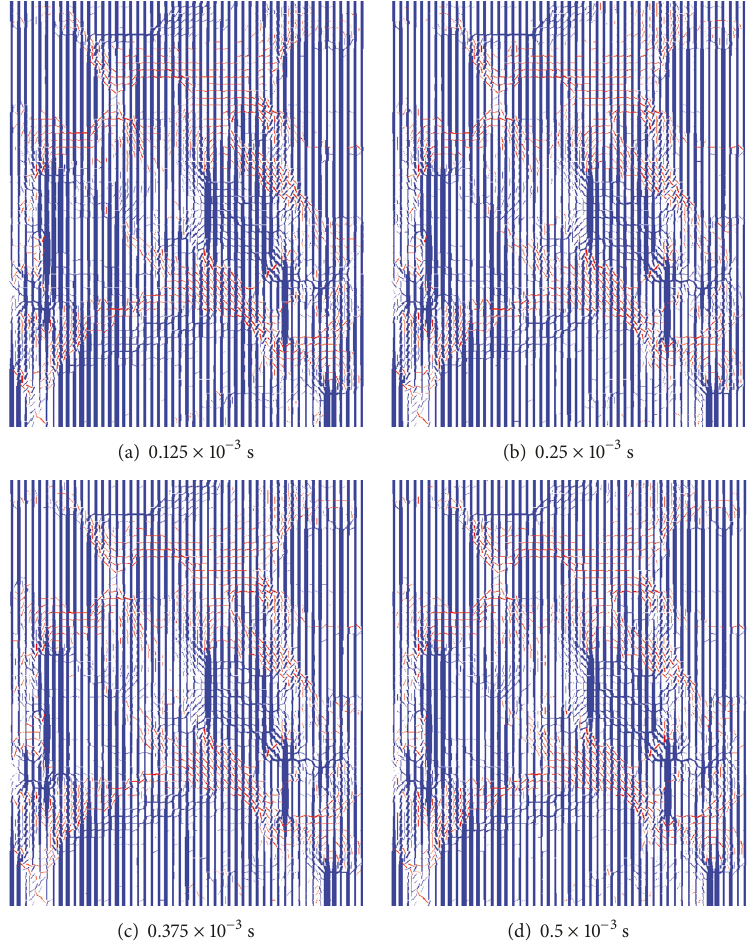
Figure 3: Force chain spatial evolution with loading times.